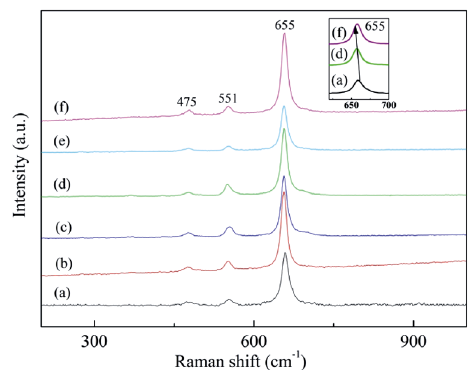
Fig. 1 Refined XRD patterns of Li 3 Mg 2 Sb 1– x O 6 ceramics sintered at 1250 ℃ .